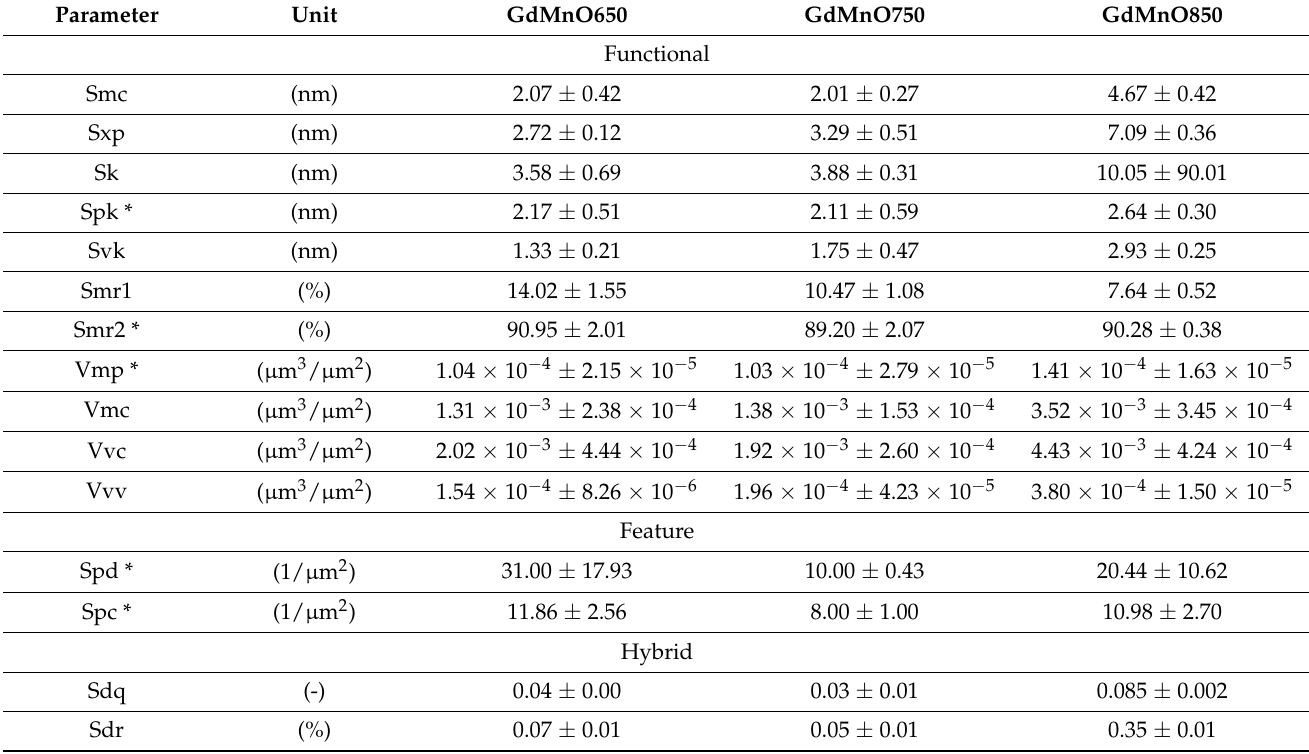
Table 3. Stereometric parameters of the GdMnO 3 thin films, in accordance with ISO 25178-2:2012. Parameter Unit GdMnO650